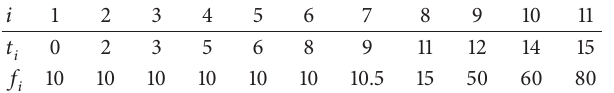
Table 4: A 2D monotone